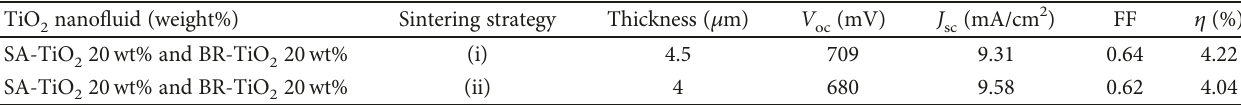
Table 3: Photovoltaic performance of DSSCs using water-based TiO nano fl uids. Two di ff erent sintering strategies were used to manufacture 2 semiconductor on FTO substrate. Sintering strategy: (i) sintered at 500 ° C for 60 minutes. The temperature raised and decreased to 500 ° C with speed of 100rpm per hour and (ii) the temperature raised to 500 ° C with speed of 100rpm per 6min and decreased to ambient temp. with speed of 100 rpm per